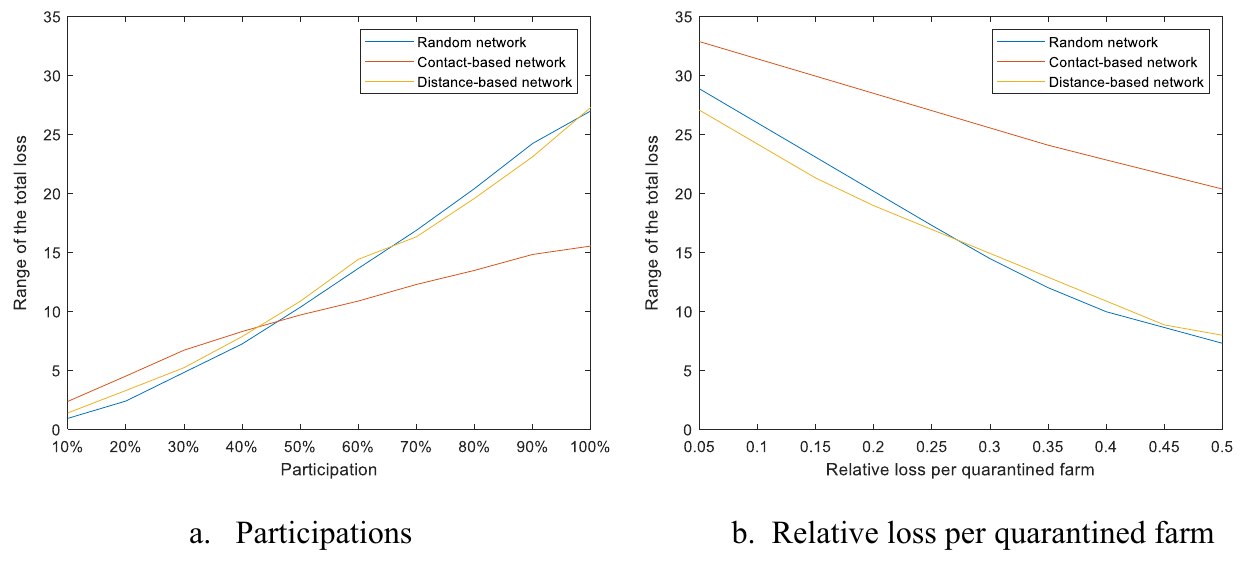
Figure 9. Range of the total loss under different participations and relative quarantine